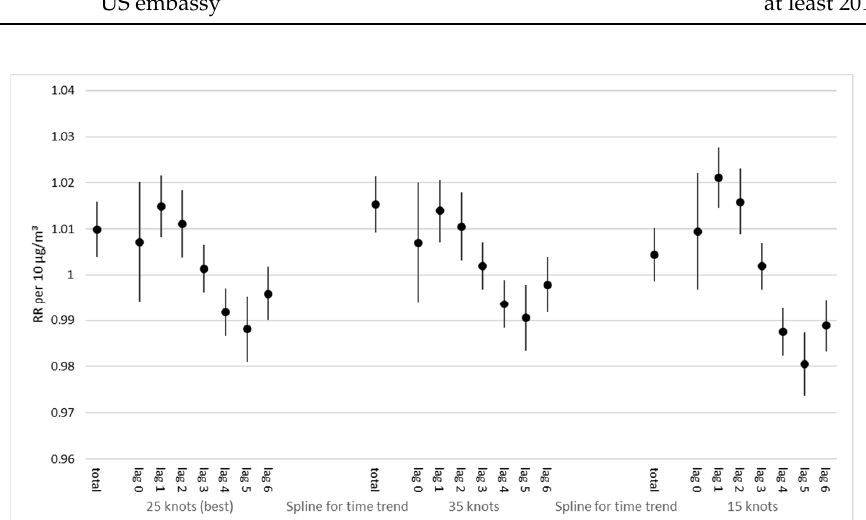
Figure A1. Sensitivity analysis: Effect (relative risk and 95% confidence interval) on ambulatory visits per 10 µ g/m 3 increase in PM2.5, total effect and daily effects over 7 consecutive days (lag 0–6): Optimal model (25 knots for the time smoother) compared to 35 and 15 knots for the 3-year period.